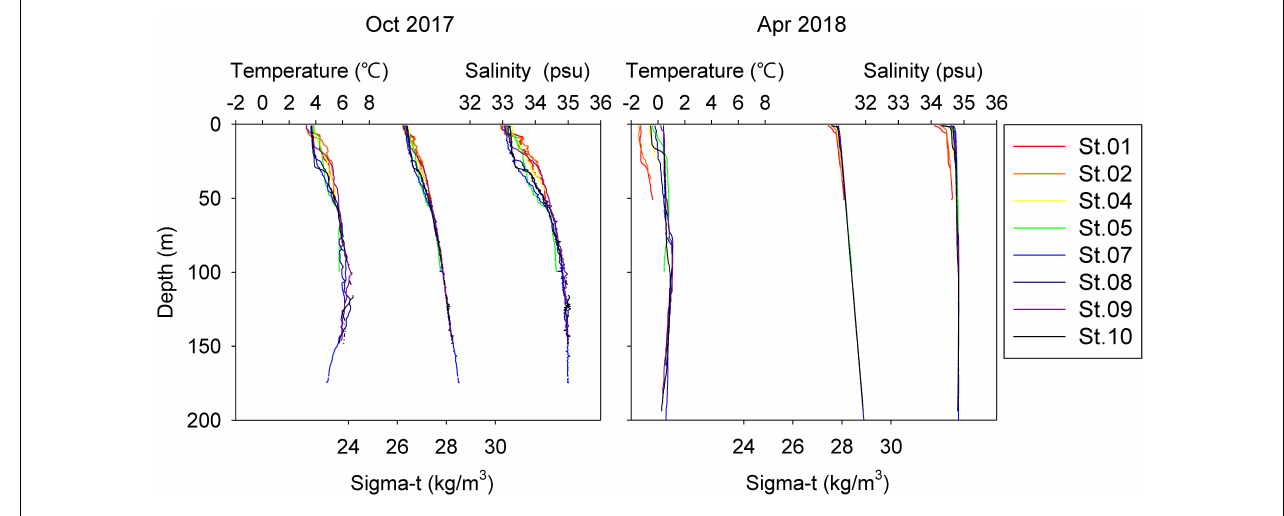
FIGURE 2 | Vertical profile of temperature, salinity, and sigma-t in sampling stations.